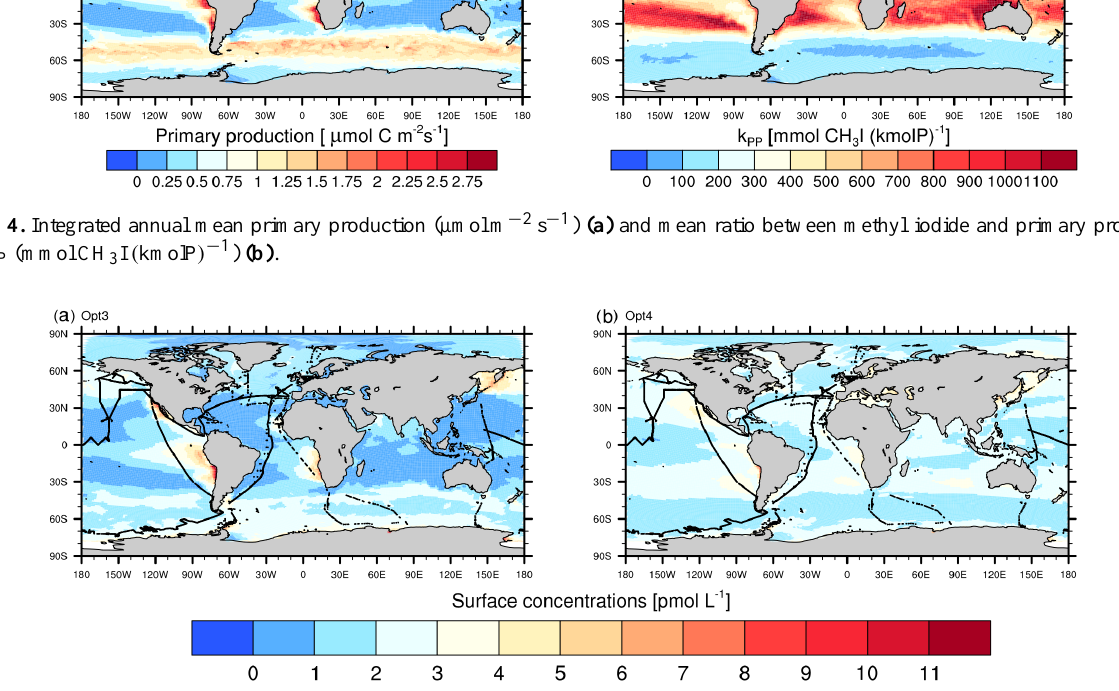
Figure 5. Annual mean methyl iodide concentration (pmolL − 1 ) in the experiment, with photochemical production from SLDOC, Opt3 (a) , and RDOC, Opt4 (b) . Black dots mark the sampling locations of the CH 3 I observations (shown in Fig.